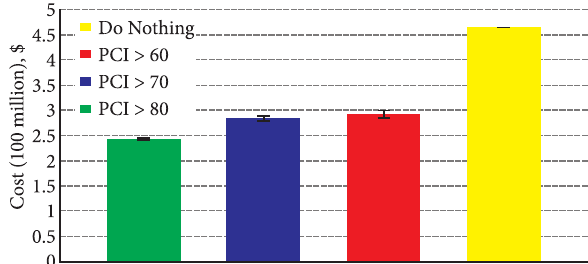
Fig. 11. Net present value for all